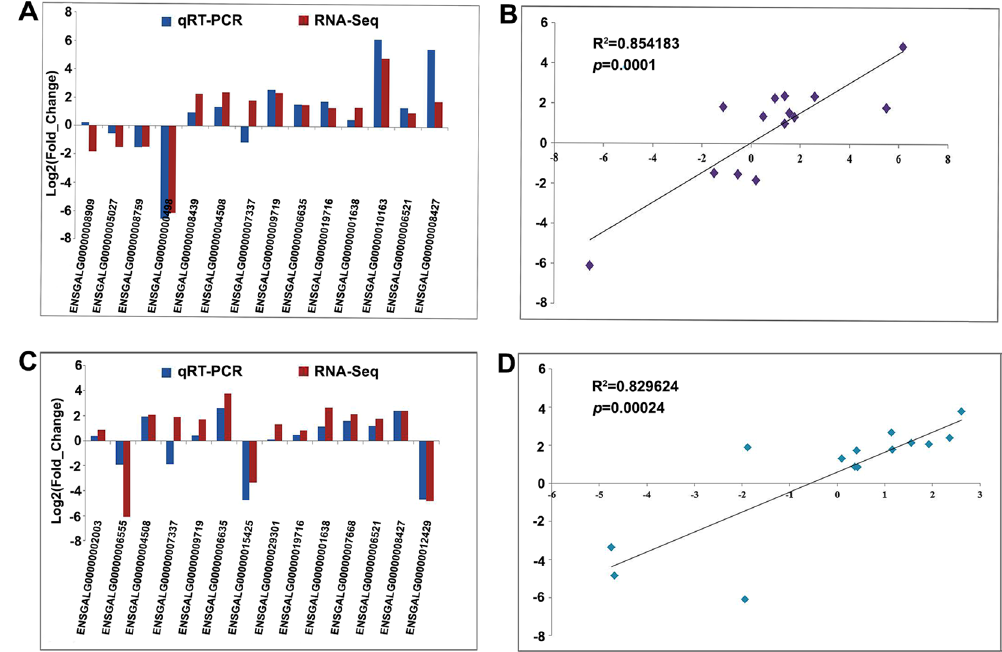
Figure 3. Correlation of expression levels of DEGs (20 in total, 8 in common in A and C ) between GE vs NGE ( A,B ) or GE vs GM ( C , D ) detected by qRT-PCR and RNA-Seq. A , C : Histograms of expression levels of 14 selected DEGs between GE vs NGE ( A ) and GE vs GM ( C ). Y-axis represents the log2 (Fold_Change) derived from qRT-PCR and RNA-Seq. B , D : Regression analysis of the log2 (Fold_Change) values between RNA-Seq and qRT-PCR. The X- and Y-axis represents the log2 (Fold_Change) measured by qRT-PCR (normalized by GAPDH) and RNA-Seq, respectively.